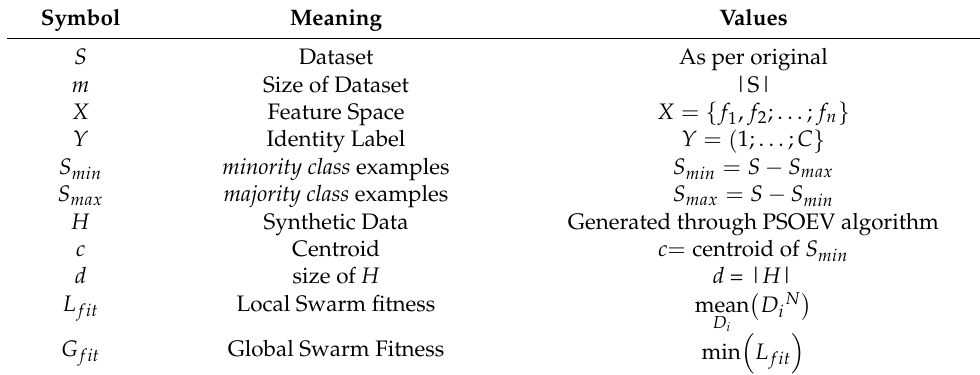
Table 1. List of symbols used and their associated